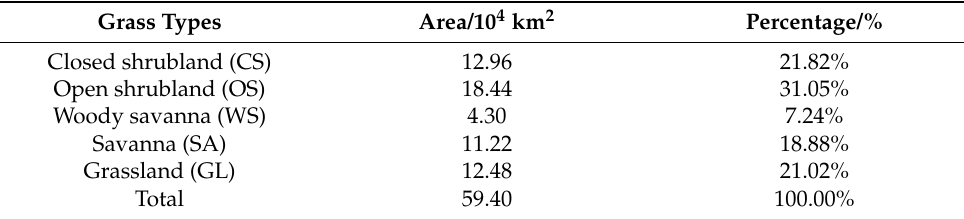
Table 3. Area and proportion of grassland types in